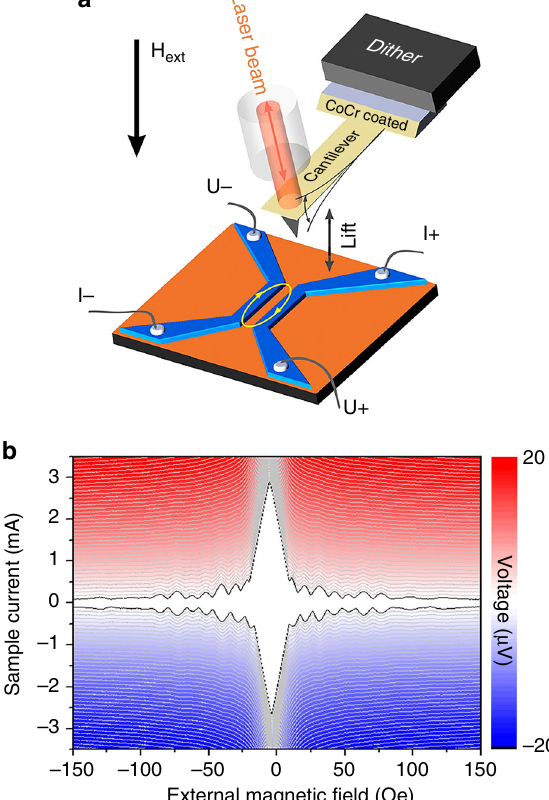
Fig. 1 Design and electronic characteristics of the studied SNS device. a experimental setup: 100-nm-thick Nb leads (in blue) are patterned on a 50-nm-thick Cu layer (in orange); the leads are bonded for transport measurements. The ellipse marks the junction region 2500 nm × 200 nm. The MFM cantilever with a Co/Cr-coated tip oscillates, excited by a dither; an optical fi ber is used for the oscillation readout; b “ Fraunhofer pattern ” of the device: the voltage drop across the junction is measured as a function of applied current and external magnetic fi eld (the MFM tip is retracted far away from the device). Red (blue): positive (negative) voltage drop; white: zero-voltage drop representing the superconducting